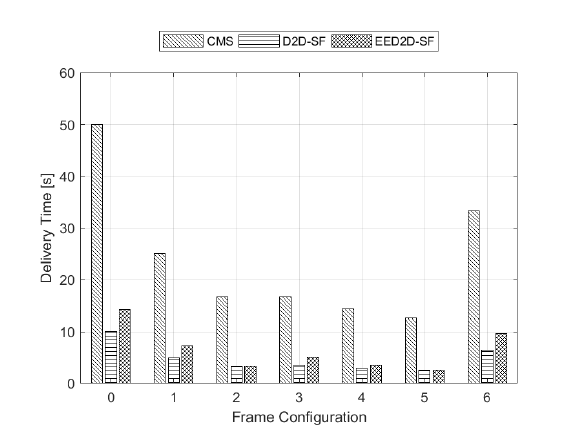
Figure 5. Delivery time for all frame